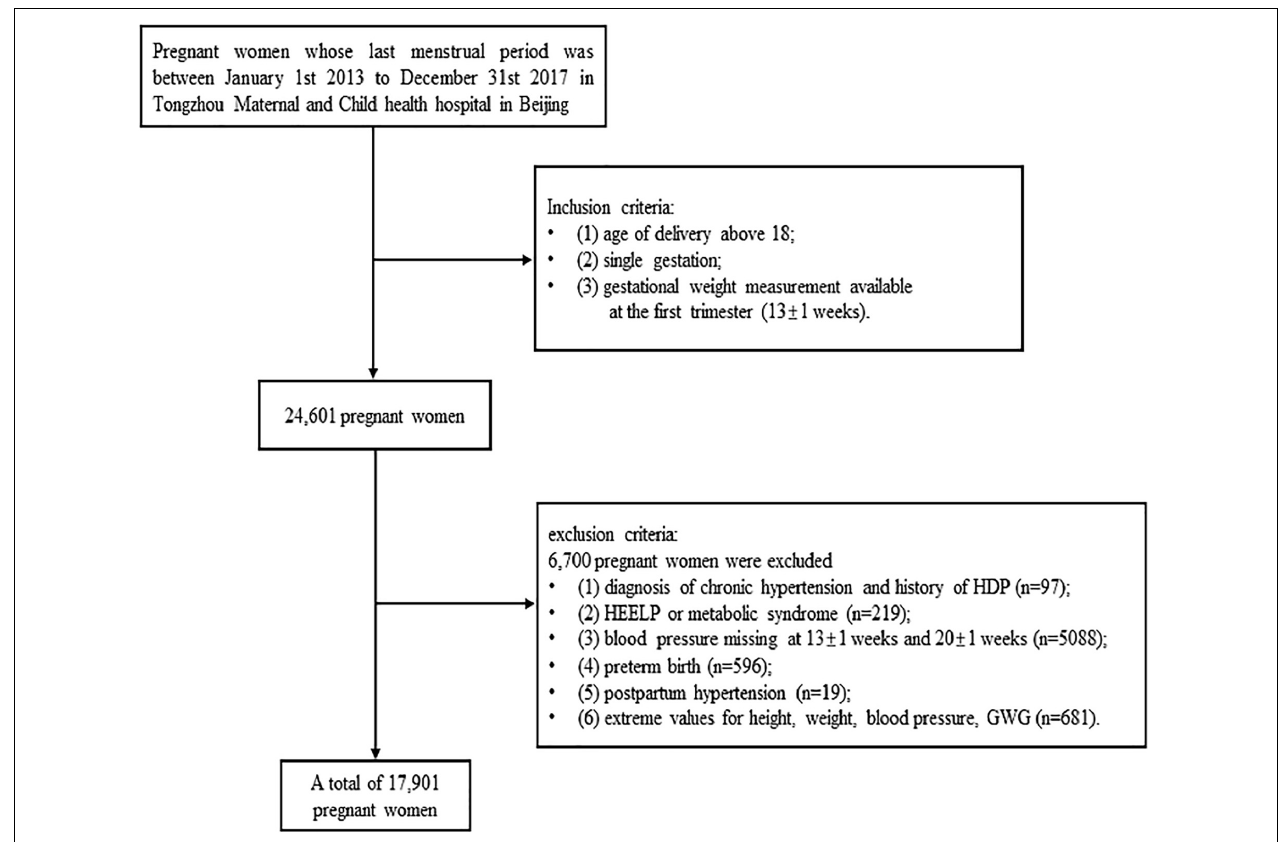
FIGURE 1 | Study flowchart. Flowchart illustrating the selection of the study population in current